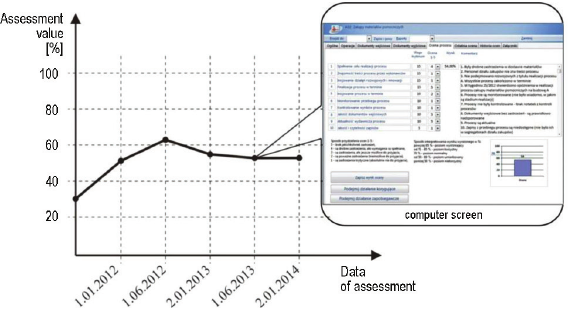
Fig. 8. an example of process